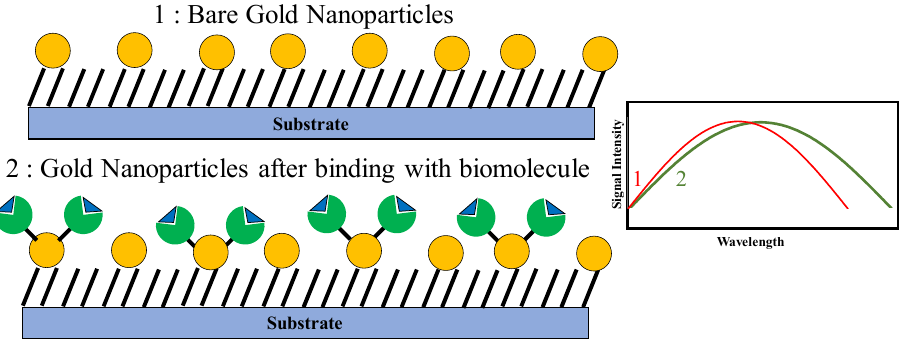
Figure 4. Gold nanoparticle (AuNP)-based biosensors. Functionalized AuNPs aid in the capture of analyte molecules. The electrical/optical properties of AuNPs are utilized to obtain enhanced signals which are proportional to the analyte concentration.